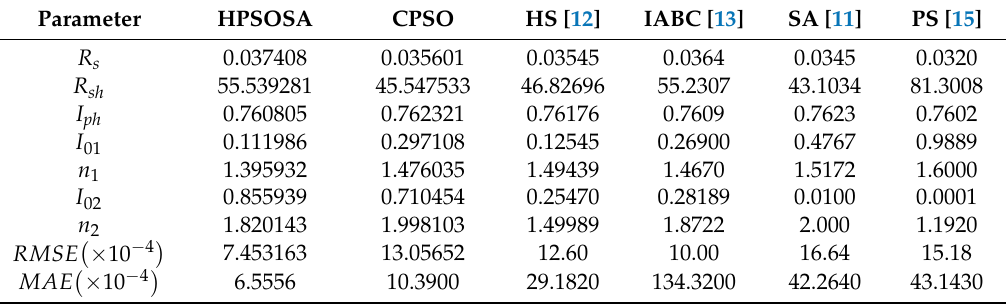
Table 6. Estimated parameters of single diode PV model obtained by HPSOSA and other five algorithms with RMSE and MAE values.